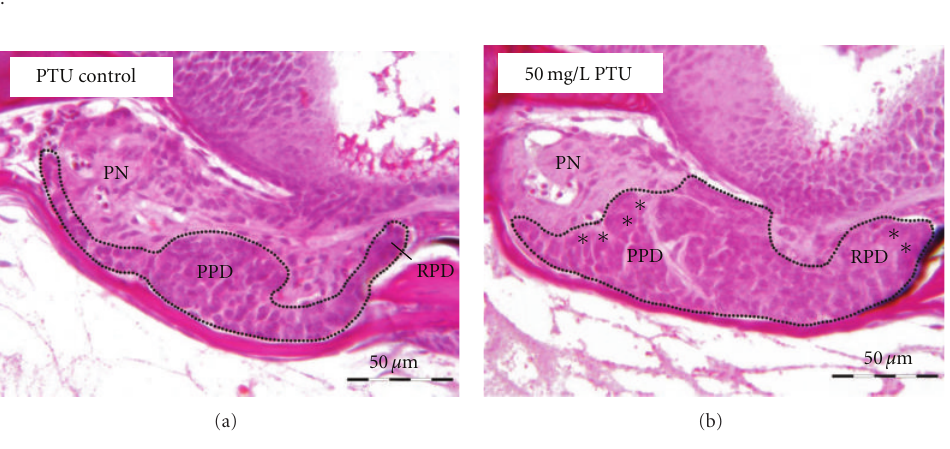
Figure 7: Representative PAS-stained sagittal sections of zebrafish ( Danio rerio ) pituitaries exposed to PTU. The adenohypophysis is encircled by a dotted line to highlight the changes in the ratio between adeno- and neurohypophysis. A massive proliferation of PAS- positive cells ( ∗ ) mostly located in the proximal pars distalis is evident. PI— pars intermedia (adenohypophysis); PN— pars nervosa (neurohypophysis); PPD—proximal pars distalis (adenohypophysis); RPD—rostral pars distalis (adenohypophysis). Sections of 2 μ m thickness stained with periodic acid-Schi ff (PAS) and Mayer’s